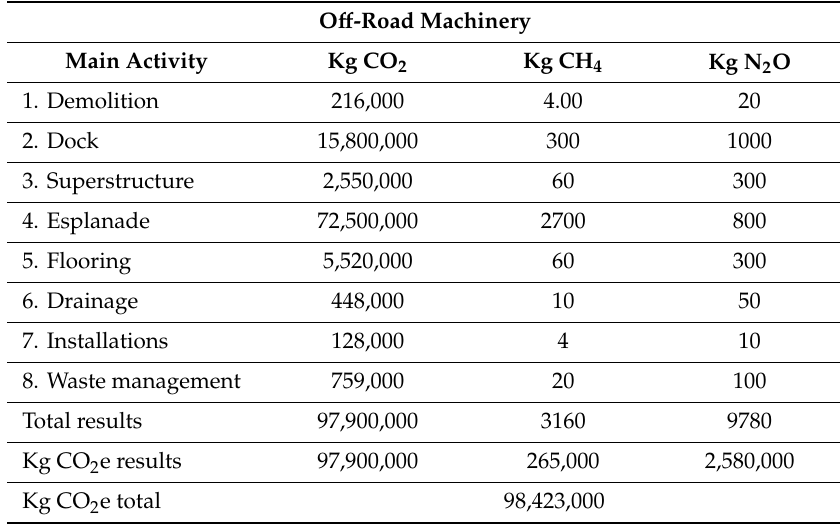
Table 4. Emissions of o ff -road machinery in construction